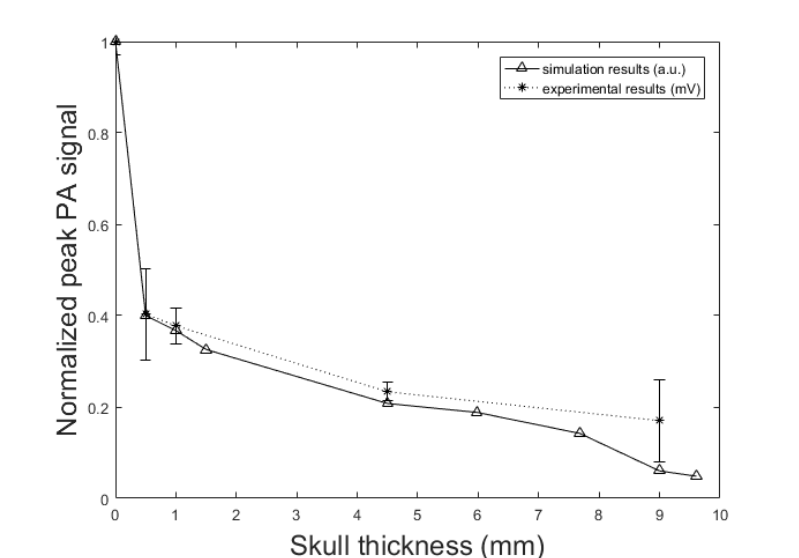
Figure 9. PA signal amplitude attenuation versus skull thickness. Simulation results (solid line) and experimental phantom results (dotted line). In simulation, the setup in Figure 2 with the parameters, d = 1.7 cm, k = 10 mm, r 0 = 1 mm, r d = 0.25 inch, and T = 5 cm is used. The thicknesses of the skull are as follow; 0.5 mm, representing mouse skull thickness, 1 mm, representing rat skull thickness, 1.5 mm, representing neonatal skull thickness, 4.5 mm, representing dog frontal skull thickness, 5.98 mm, and 7.68 mm, representing human frontal skull thickness, 9 mm, representing dog parietal skull thickness, and 9.61 mm, representing human frontal skull